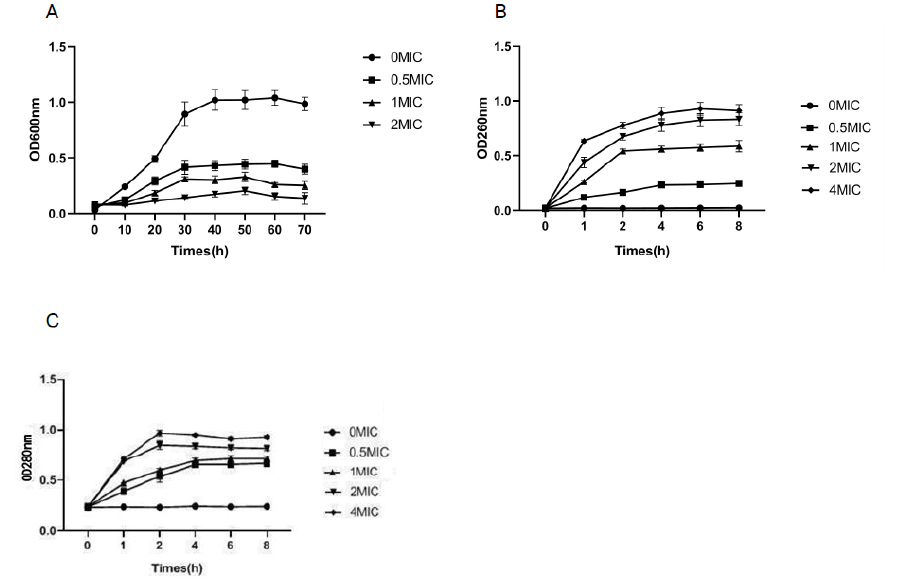
Figure 1. Effects of different amounts of lemon verbena essential oil on Pseudomonas D4 . ( A ) Growth curve of Pseudomonas D4 under different concentrations of lemon verbena essential oil. ( B ) Absorbance of Pseudomonas D4 exposed to different concentrations of lemon verbena essential oil at 260 nm. ( C ) Absorbance of Pseudomonas D4 exposed to different concentrations of lemon verbena essential oil at 280 nm.